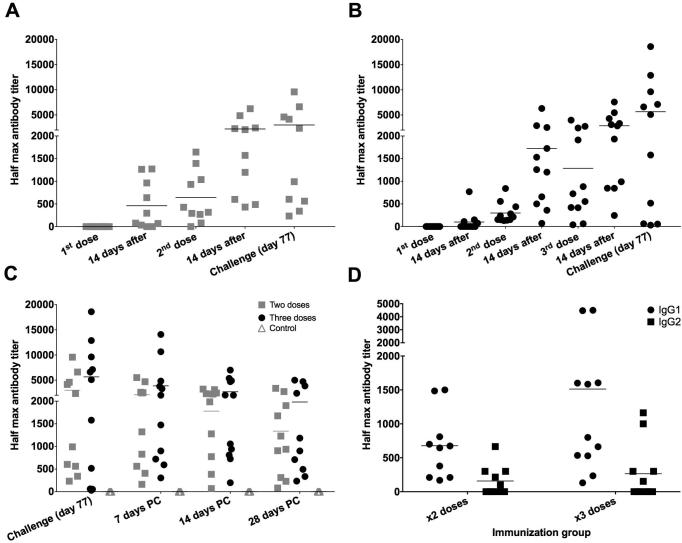
Kinetics of p67C specific IgG and IgG1 and IgG2 subtypes half max antibody titers. Antibody titers were measured by ELISA. (A) Group 1 IgG titers, two doses and (B) Group 2 IgG titers, three doses, before challenge; (C) comparative IgG antibody kinetics between Group 1 (2 doses) grey squares and Group 2 (3 doses) black dots, and the control group, grey triangles, post-challenge (PC). (D) p67C subtype specific antibody titers (IgG1 and IgG2) at the day of challenge for all immunized groups. Individual half maximal antibody titers are shown and the group means are also shown (black bar).